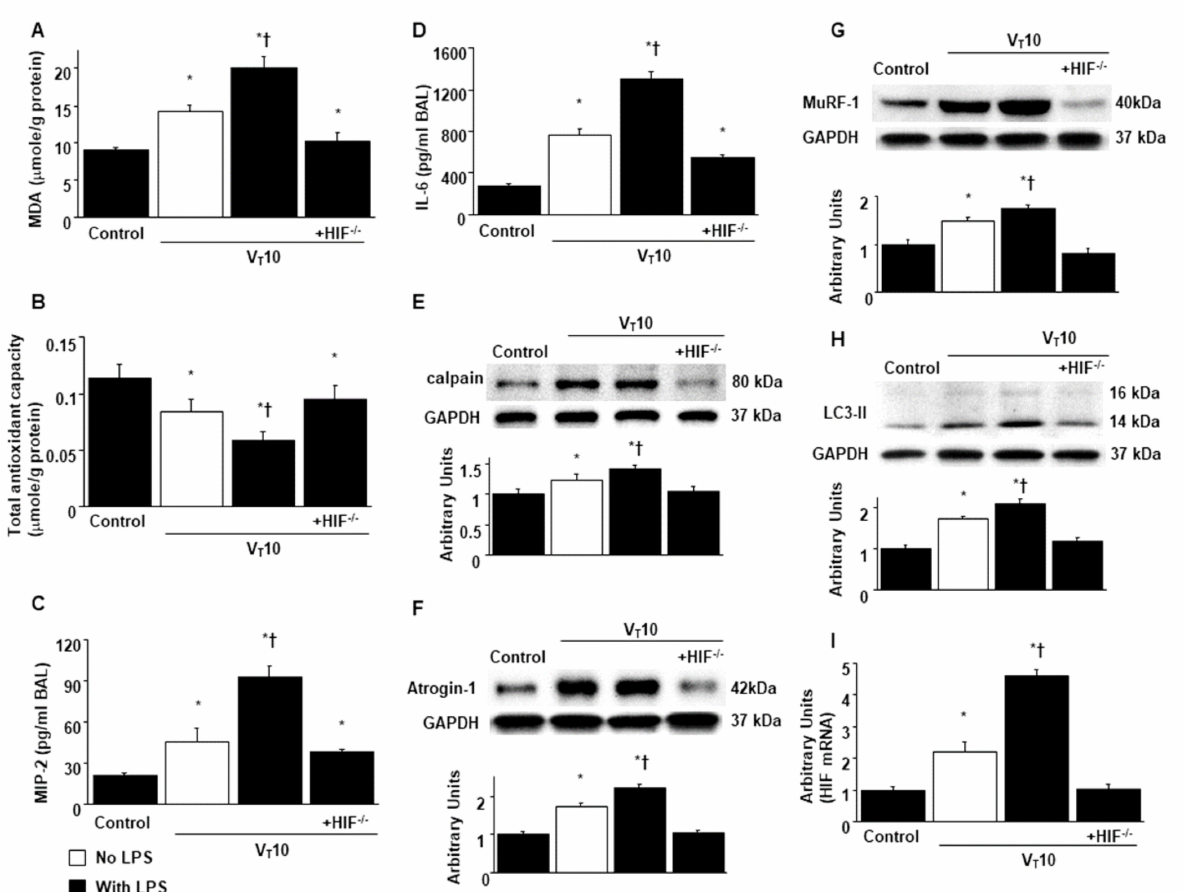
Figure 5. Abrogation of endotoxin-stimulated mechanical ventilation-mediated diaphragm dysfunction in HIF-1 α deficient mice. ( A ) MDA (diaphragm), ( B ) total antioxidant capacity (diaphragm), ( C ) BAL fluid MIP-2, and ( D ) BAL fluid IL-6 were from the non-ventilated control mice and mice ventilated at a tidal volume of 10 mL/kg for 8 h with or without LPS administration (n = 5 per group). Western blots were performed using antibodies that recognize calpain ( E ), atrogin-1 ( F ), MuRF-1 ( G ), LC3-II (H), and GAPDH expression from the diaphragms of non-ventilated control mice and mice ventilated at a tidal volume of 10 mL/kg for 8 h with or without LPS administration (n = 5 per group). Arbitrary units were expressed as relative calpain, atrogin-1, MuRF-1, and LC3-II activation (n = 5 per group). ( I ) Real-time PCR performed for HIF-1 α mRNA expression was from the diaphragms of non-ventilated control mice and mice ventilated at a tidal volume of 10 mL/kg for 8 h with or without LPS administration (n = 5 per group). Arbitrary units were expressed as the ratio of HIF-1 α mRNA to GAPDH (n = 5 per group). * p < 0.05 versus the non-ventilated control mice with LPS; † p < 0.05 versus HIF-1 α -deficient mice. HIF − / − = hypoxia inducible factor-1 α -deficient